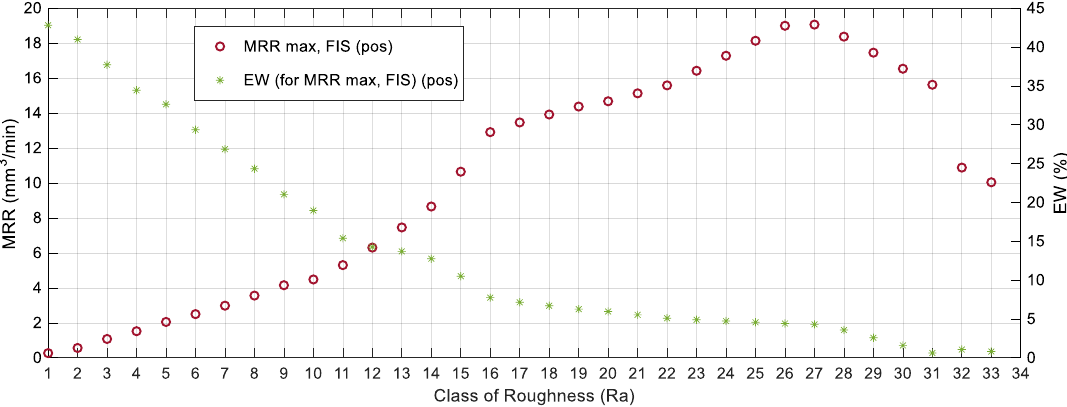
Figure 16. Values obtained from the technological table with the fuzzy inference system for the strategy of maximum removal rate using positive polarity.